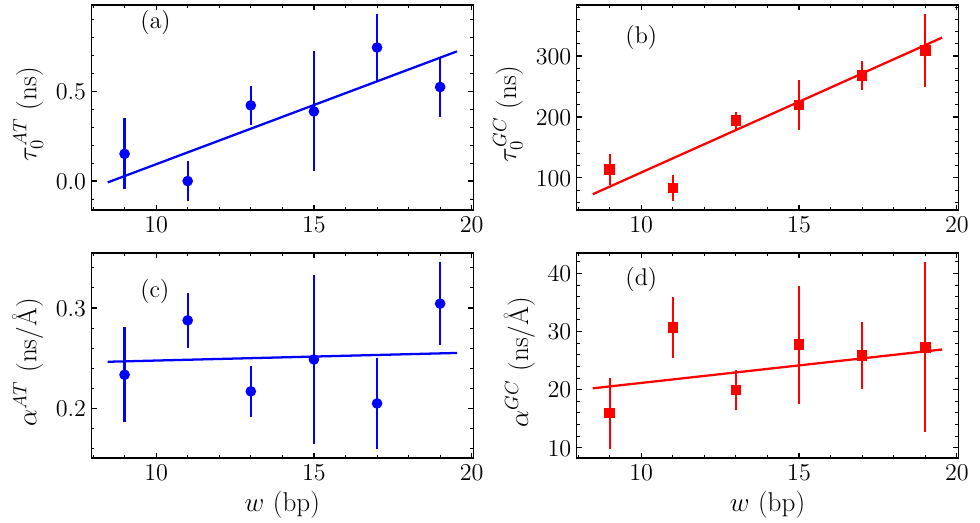
Figure 6. The variation of the parameters of linear fittings in τ av (see the straight lines shown in Figure 5 and Equation (12)) with the width w measured in number of base pairs (bp). The vertical intercept τ 0 is shown in ( a ) for AT sequences and in ( b ) for GC sequences, while the slope α is presented in ( c ) for AT homopolymers and in ( d ) for the GC ones (points). The data in all panels are in turn fitted with a straight lines (continuous